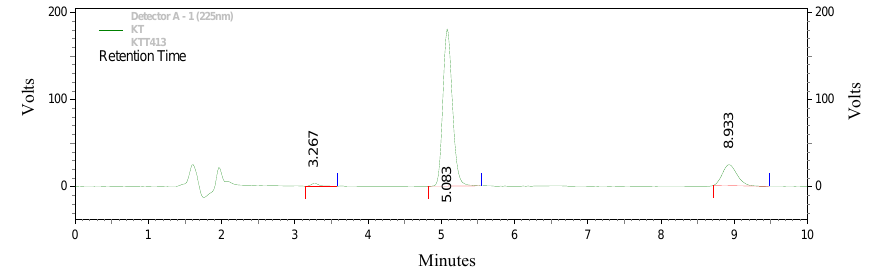
Figure 8. Degradation of metaxalone in reductive conditions (Retention time of metaxalone is 5.083 min and IS (Gliclazide) is 8.933